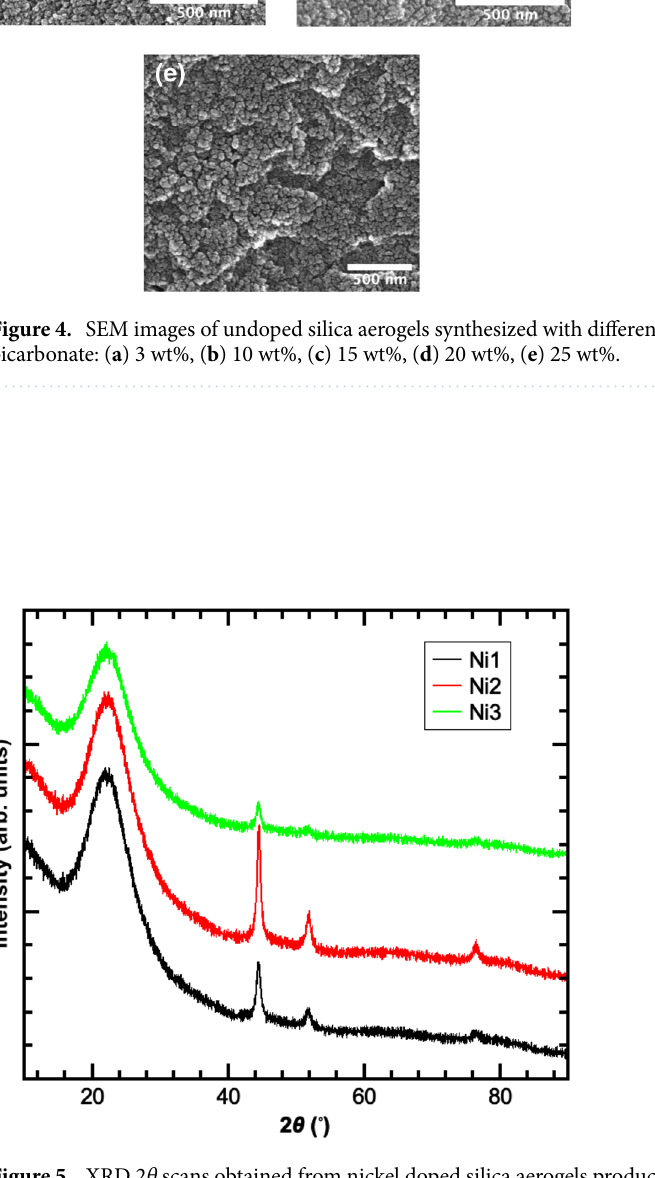
Figure 5. XRD 2 θ scans obtained from nickel doped silica aerogels produced with varying concentrations of sodium